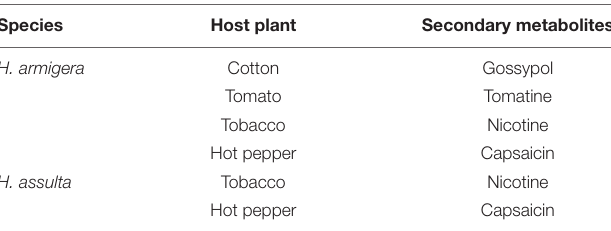
TABLE 1 | The investigated plant metabolites and the corresponding host plants of the two Helicoverpa species.